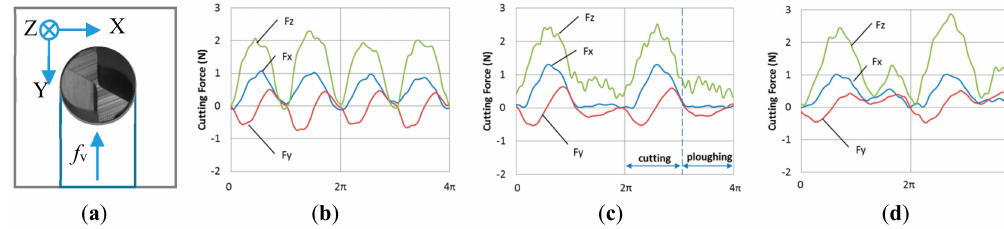
Figure 10. Typical milling force signals in the test, ( a ) coordinate system description; ( b ) evenly milling by two cutting edges; ( c ) single edge cutting; ( d ) unevenly milling by two cutting